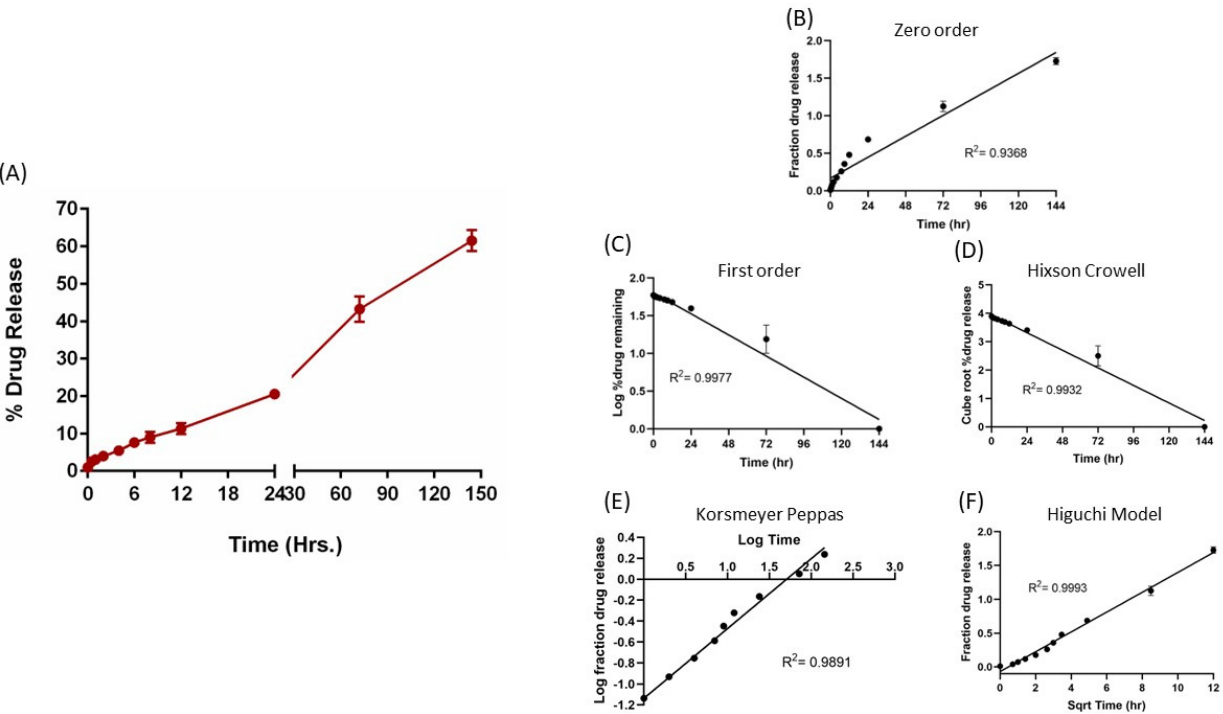
Figure 3. In vitro drug release profile of E5-1 nanoemulsion in phosphate buffer saline containing 1% Tween 80 at 37 ◦ C/100 RPM using the membrane method ( A ). Drug release data fitted to various kinetics models: zero-order model ( B ), first-order model ( C ), Hixson–Crowell model ( D ), Kosmeyer–Peppas model ( E ), and Higuchi model ( F ), with the corresponding R 2 values. Data repre- sent mean ± SD (n = 3).